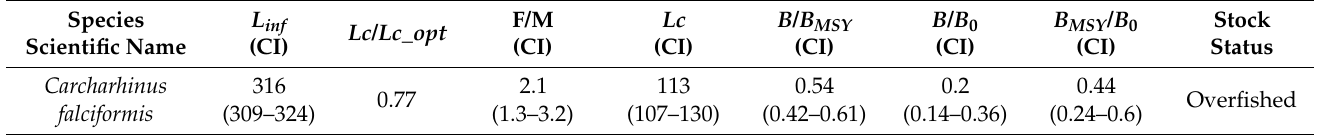
Table 4. Results of LBB analysis with the stock status of silky sharks in the Pacific Ocean. Proxies of the stock status presented by the LBB ( L inf , Lc/Lc_op t, L c , F/M, and B/B 0 , B/B MSY , B MSY /B 0 and their respective 95% confidence intervals (numbers in